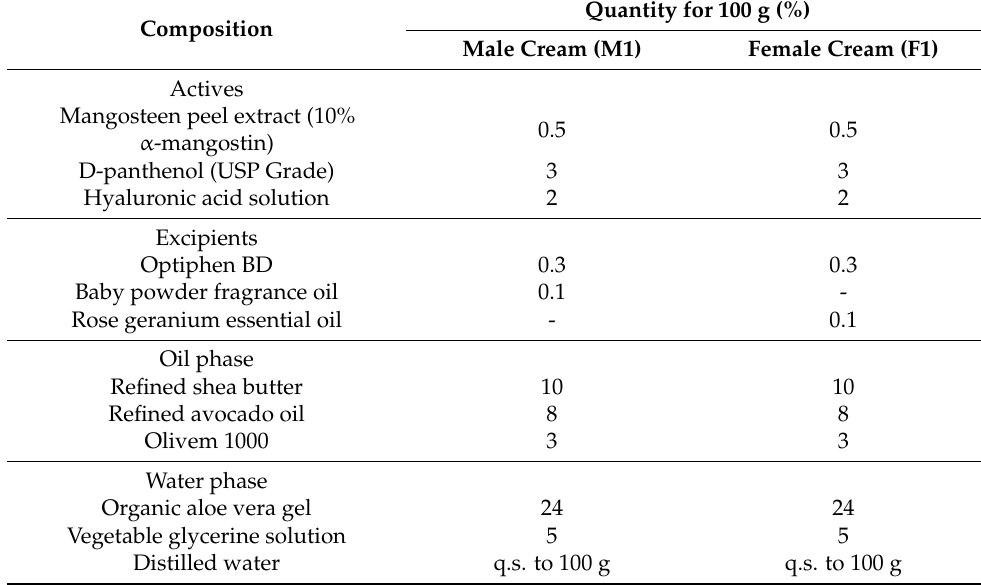
Table 1. Formulation of mangosteen creams.